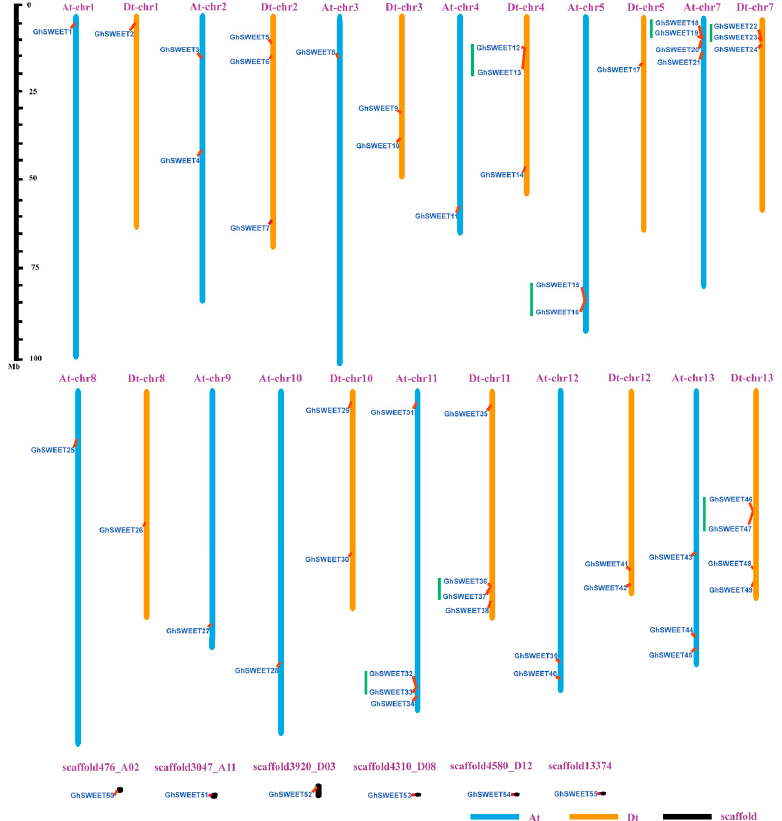
Figure 3. Chromosomal distribution of GhSWEET genes. Blue, orange and black indicate the At subgenome chromosomes, Dt subgeome chromosomes, and scaffolds, respectively. Green lines indicate tandem duplicated genes. The scale is provided in megabases.